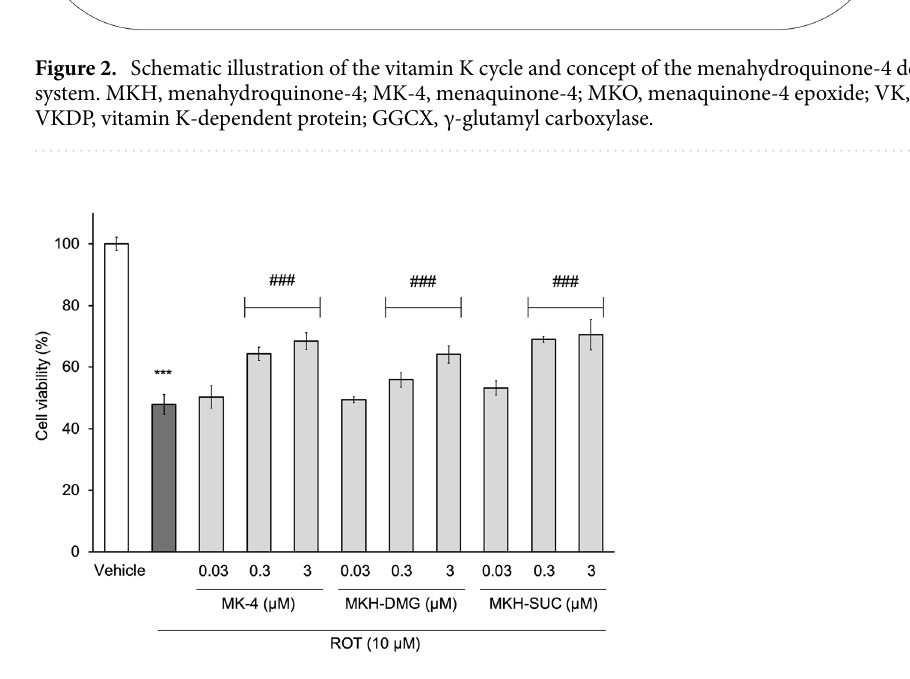
Figure 3. Influence of MK-4 and MKH derivatives on ROT-induced cell death. The NIH/3T3 cells were treated with 0.03 ‒ 3 µM MK-4, MKH-DMG, or MKH-SUC for 24 h in the presence of 10 µM ROT. Cell viability was determined using the CTB assay. ***p < 0.001 versus vehicle group (0.1% DMSO + 0.1% ethanol); ### p < 0.001 versus ROT only group (Tukey’s test). Mean ± SD (n =